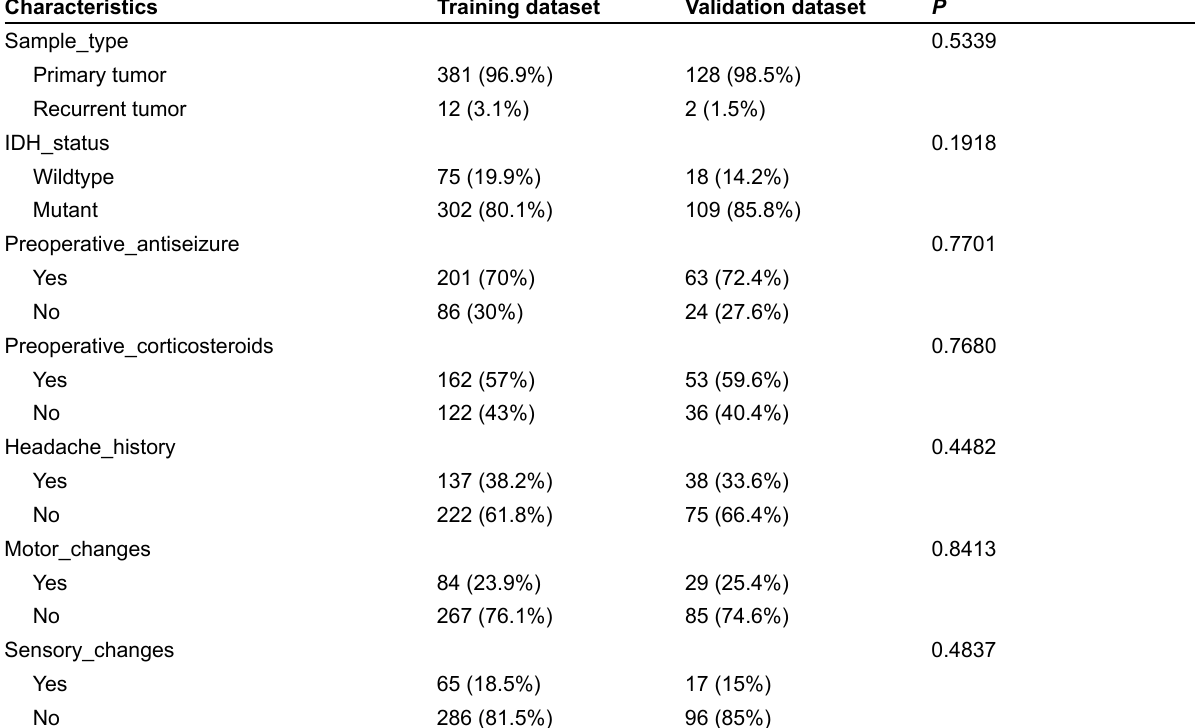
Table 1. Characteristics of LGGs in the training and validation cohorts ( continued )